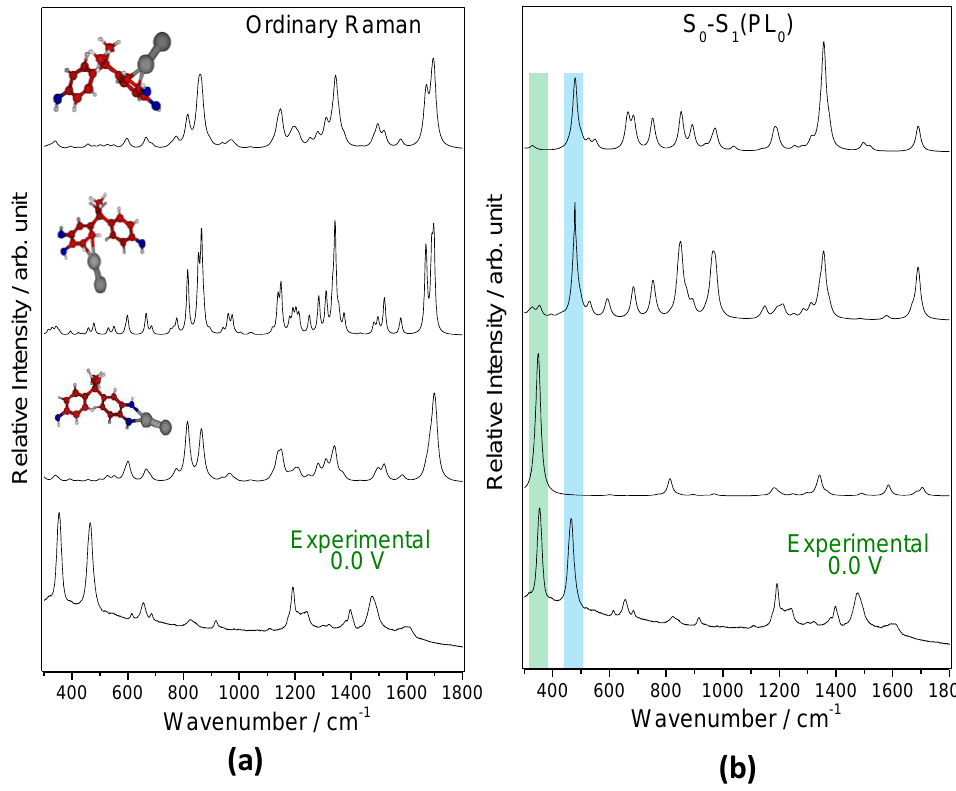
Figure 5. Calculated ( a ) ordinary and ( b ) resonance Raman spectra of the Ag 2 -BPA(OH) complex with different silver coordination. SERS spectrum at 0.0 V is plotted at the bottom.